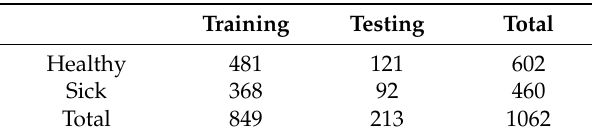
Table 3. Dataset repartition use for